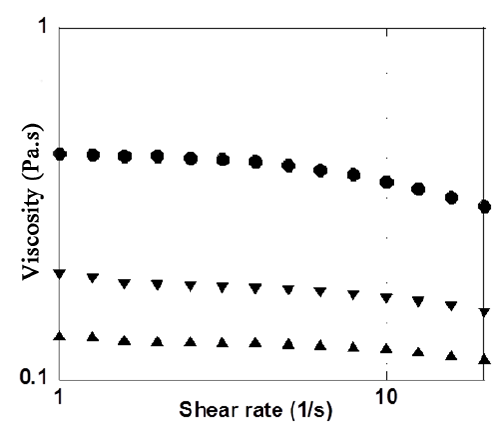
Figure 1. Measurement of the steady state viscosity  as a function of the shear rate for 3 solutions of hyaluronic acid (HA) at pH = 7.4:  initial HA in phosphate (PBS);  HA/PBS + xanthine;  HA/PBS + xanthine + xanthine